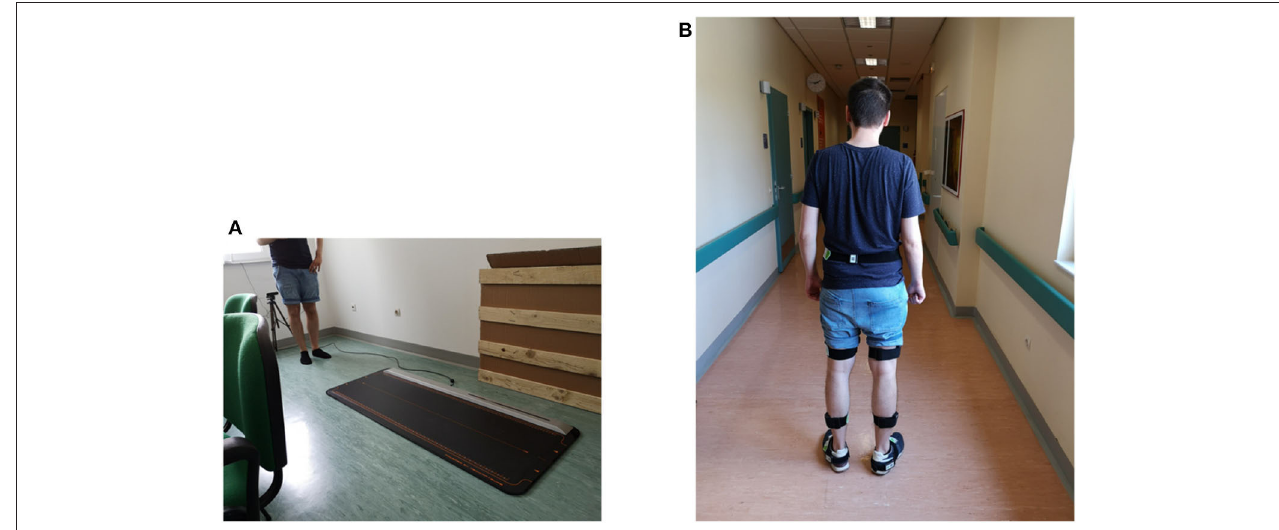
FIGURE 5 | Experimental setups for validating gait parameters: (A) Comparison with the WinTrack © system, and (B) comparison with the RehaGait © system).